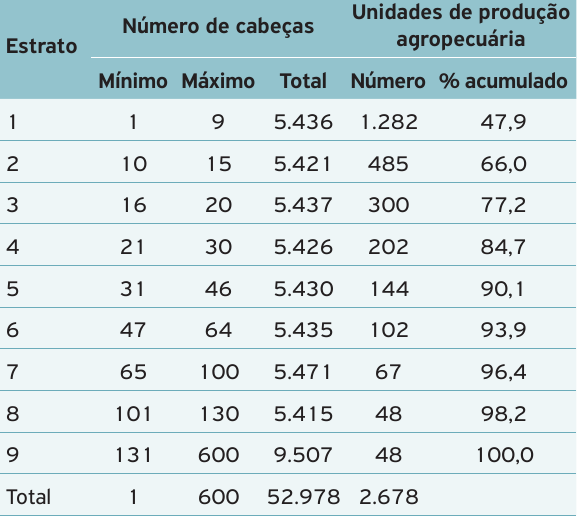
Tabela 1. Número de unidades de produção agropecuária com caprinocultura, por faixa de número de cabeças, estado de São Paulo, 2007/2008.